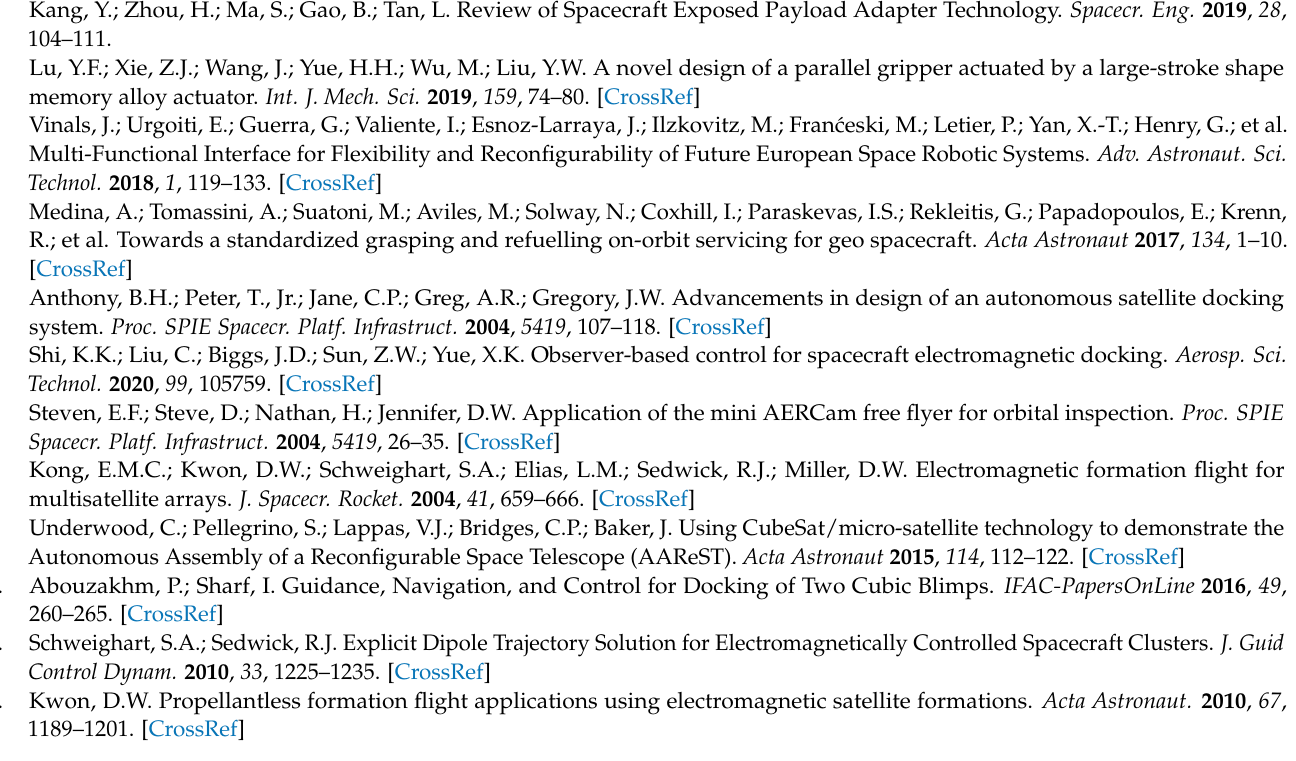
Figure S4 Structural parameters of electromagnetic docking device; Table S1: Design requirements for electromagnetic docking